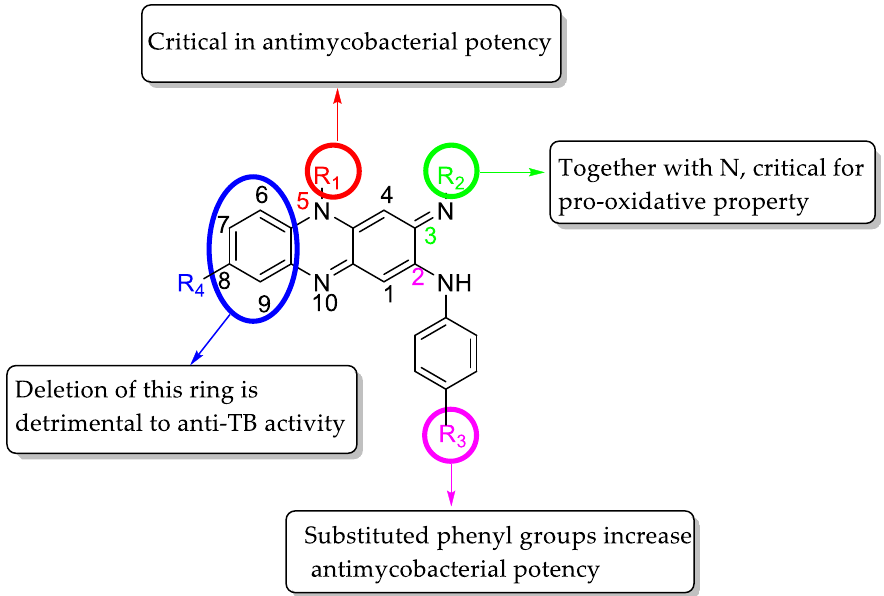
Figure 2. Structure–activity relationships of the riminophenazine system. IUPAC numbering is included for reference. Substituents targeted in this investigation are labeled R 1 –R 4 .